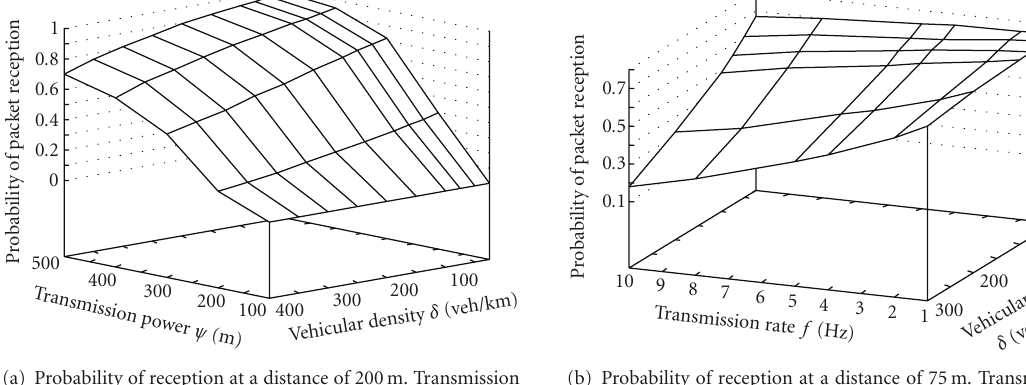
Figure 2: Probability of packet reception according to various configuration parameters.